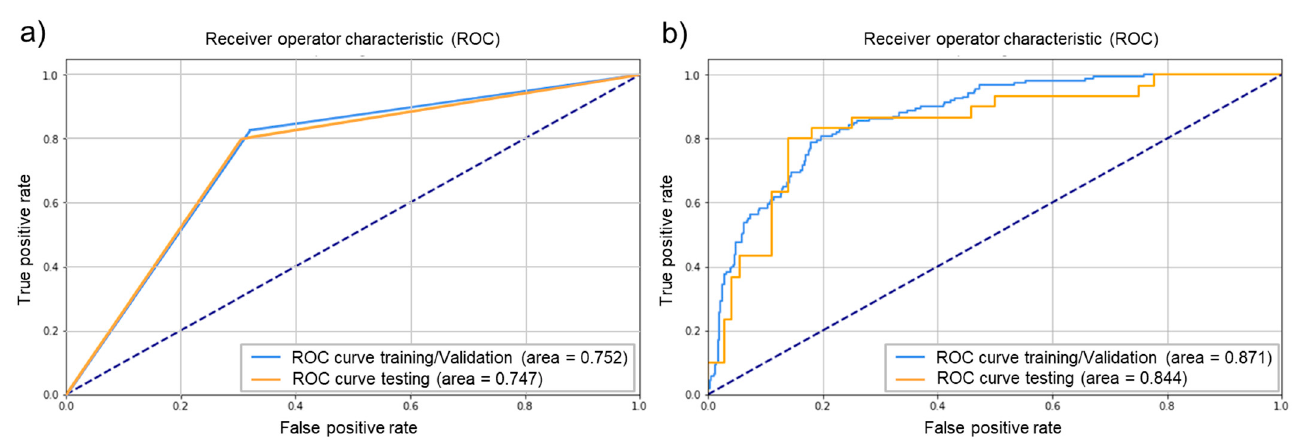
Figure 4. Receiver operator characteristic curves of the best support vector machine ( a ) and multilayer perceptron ( b ) models.